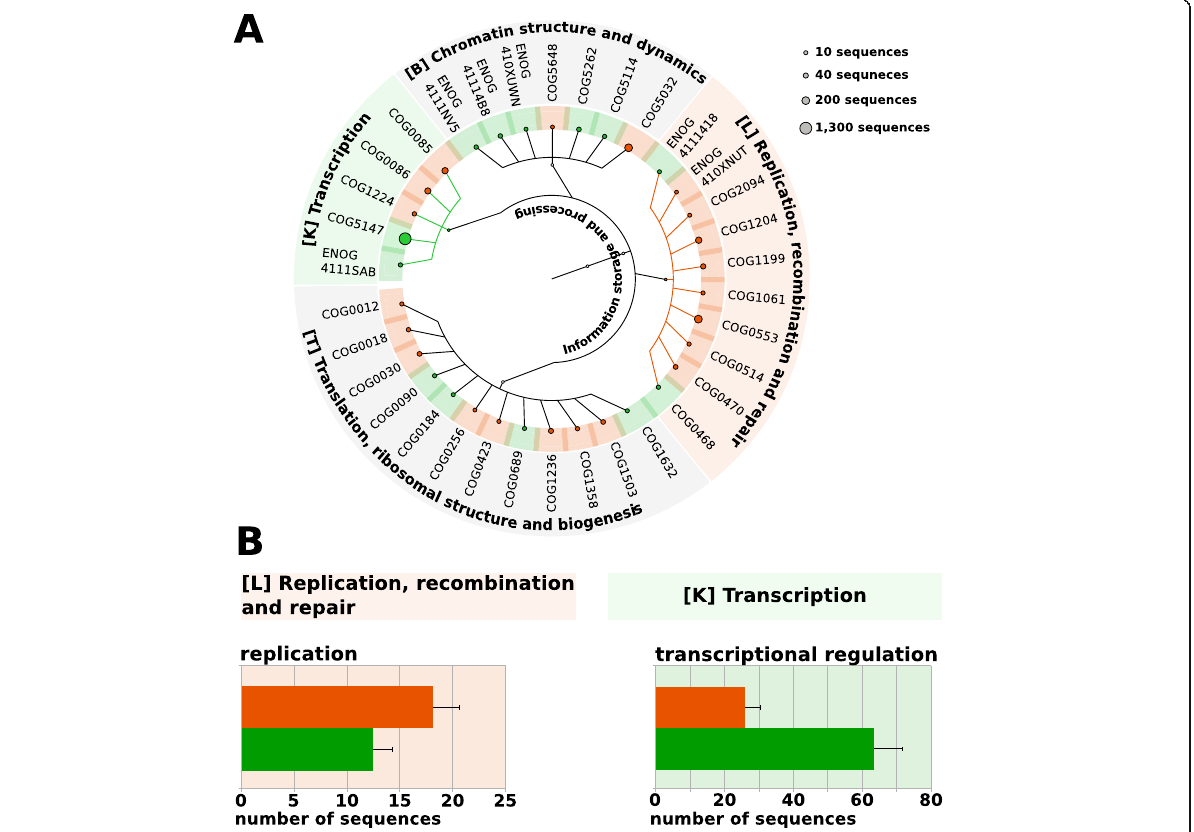
Fig. 3 Differences in the functional content of the protist metagenomes of wood-dwelling and foraging species. a Circular dendrogram/hierarchy of all over-represented COGs in the category “ information storage and processing ” in wood-dwelling species (green) or foraging species (orange). Circle size at the edges scales with abundance of the COG. Colored branches indicate over-represented pathways. Over-representation was detected with LEfSe [58] ( p <0.05, q<0.05, LDA>2). A Venn diagram visualizing the total number, and the differentially abundant number of functions in each of the five pathways that constitute the category “ information storage and processing ” can be found in Additional file 1: Fig. S6. b Sequence coverage of wood-dwelling (green) and foraging (orange) species of examples of over-represented COGs mentioned in the text. Error bars represent 95% confidence intervals across replicate